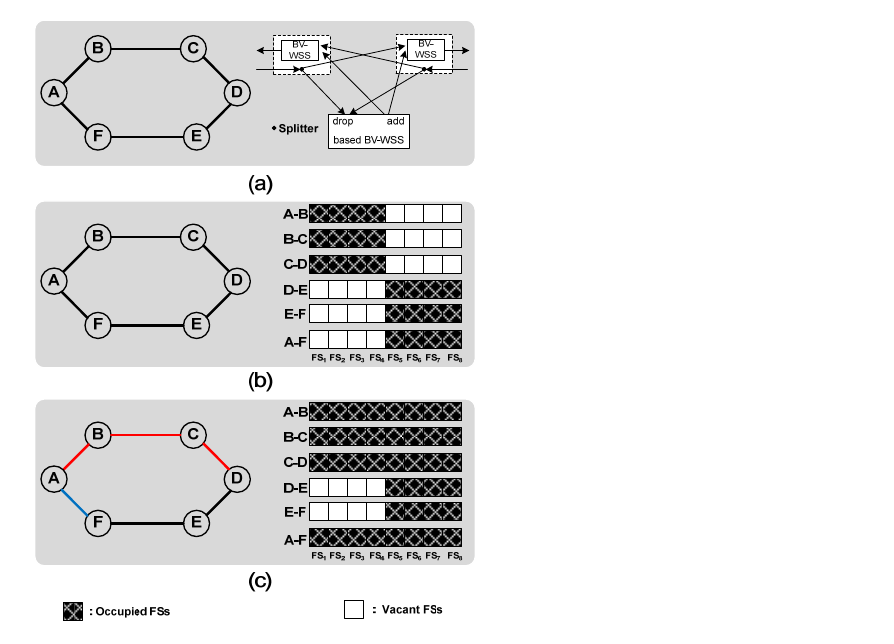
Figure 1. An illustrative example for the path routing and spectrum allocation in a six-node network when employing the proposed PFS MRSA algorithm: ( a ) the employed network topology and the node architecture; ( b ) the spectrum utilization on each link before multicast request M 0 arrives; ( c ) the path routing and spectrum allocation for M 0 when the proposed algorithm is used.